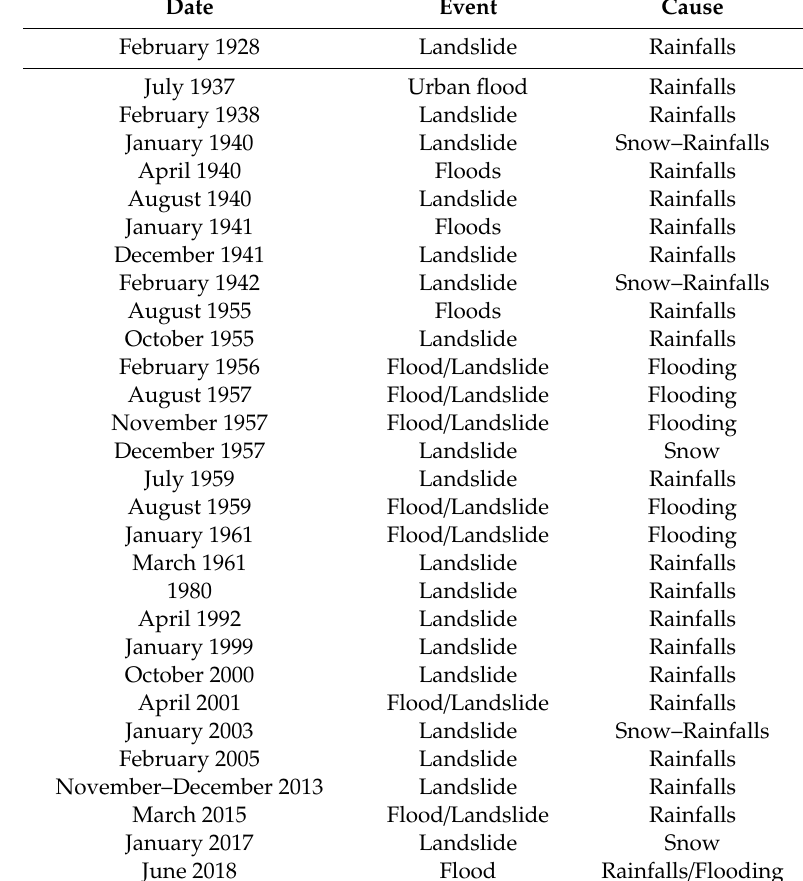
Table 1. Summary of the historical (1928–1961 [59]) and recent rainfall-induced flood and landslide events, which a ff ected and caused damage in the Lanciano area and the Feltrino